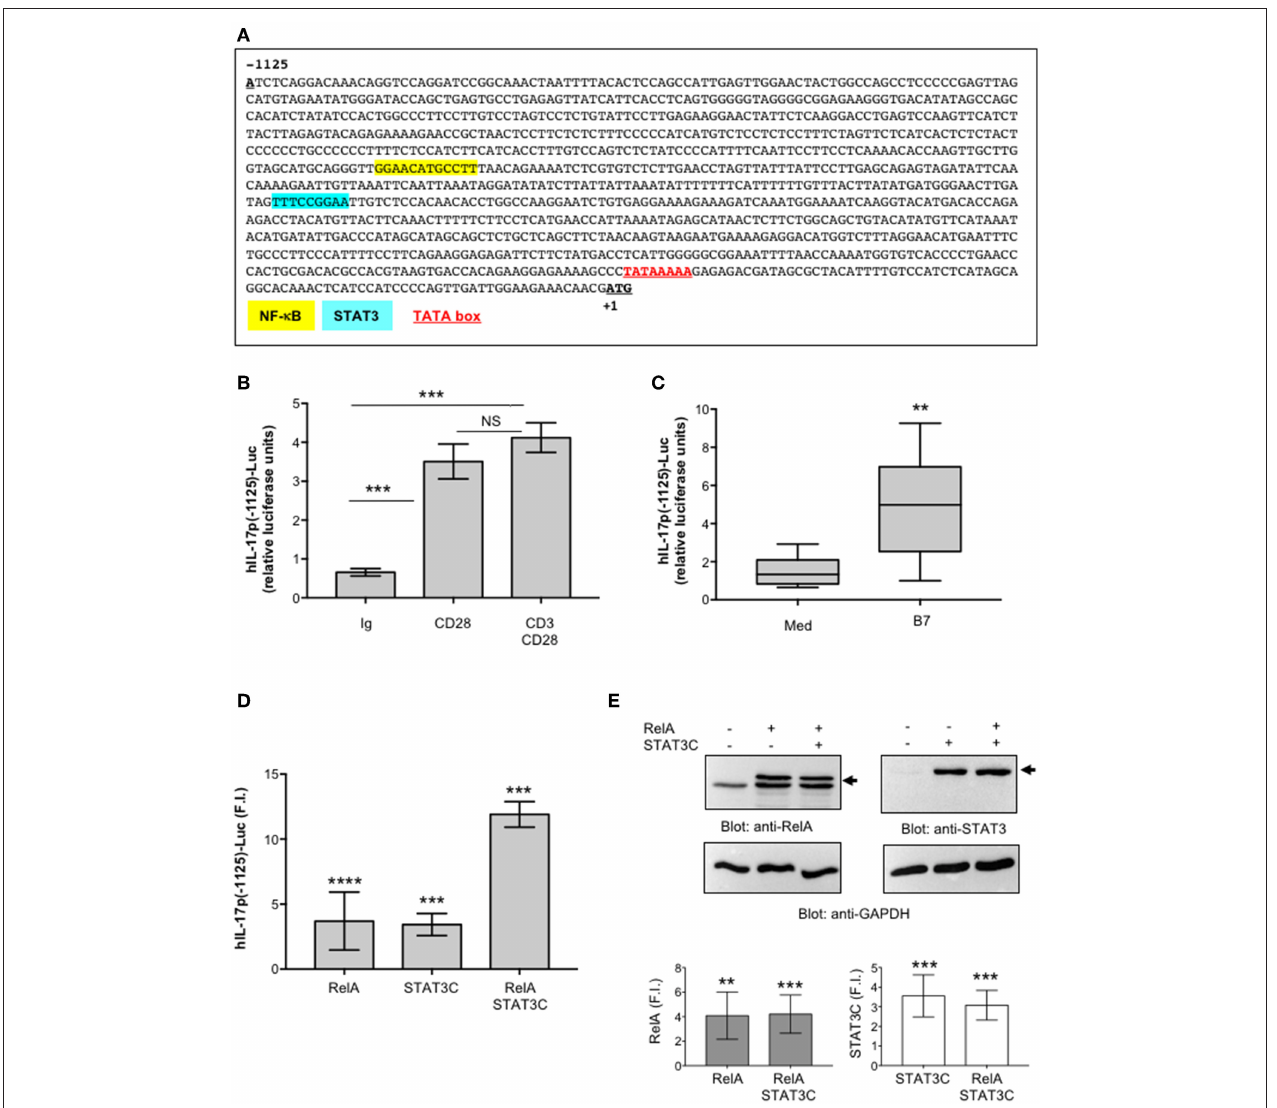
FIGURE 5 | STAT3 and RelA/NF- κ B transcription factors regulate CD28-mediated transactivation of IL-17A promoter. (A) Sequence of the 1.2kb region upstream of the transcriptional start point of human IL-17A gene. The binding sites of NF- κ B (yellow), STAT3 (light blue), and the TATA box (red) are indicated. (B) CD28-positive Jurkat cells were transfected with 5 µ g pGL3E-hIL-17prom(-1125)-luciferase construct [hIL-17p(-1125)-Luc] and then stimulated for 6h with isotype control Abs (Ig), or anti-CD28.2, or anti-CD3 (UCHT1) plus anti-CD28.2 Abs. The results are expressed as the mean of luciferase units ± SD. Significance was calculated by Student t -test. *** p < 0.001. NS, not significant. Mean ± SD: Ctr = 0.65 ± 0.09, B7 = 3.5 ± 0.53, CD28 = 3.5 ± 0.44, CD3/CD28 = 4.12 ± 0.38 The data are representative of three independent experiments. (C) hIL-17p(-1125)-luciferase activity of Jurkat cells stimulated for 6h with medium (Med) or Dap3/B7 (B7) cells. Lines